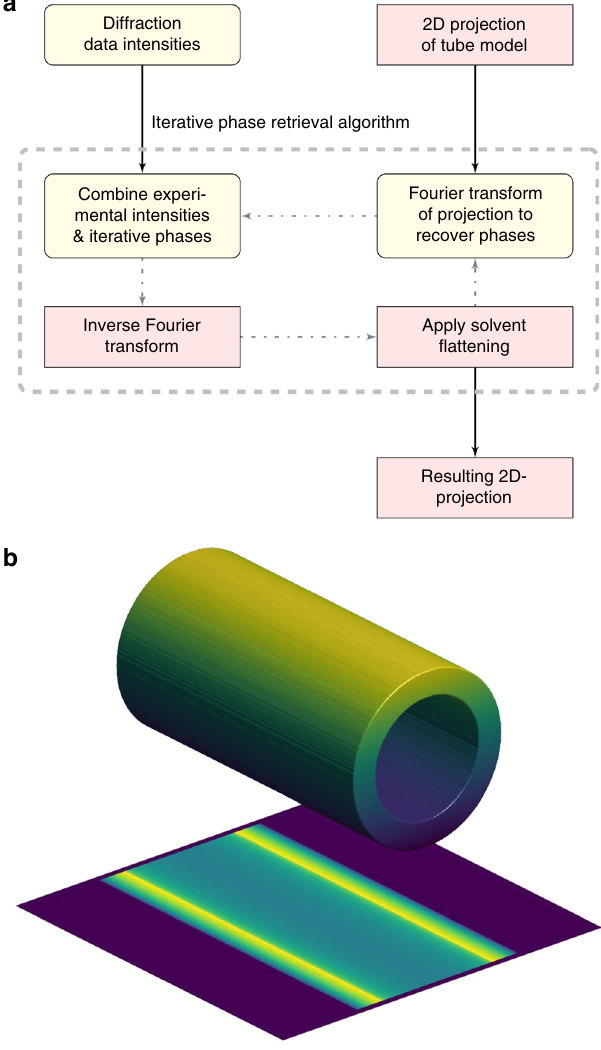
Fig. 4 Iterative phase retrieval algorithm. a Flow chart illustrating the input of X-ray diffraction data, initial phases, application of solvent fl attening (support function) and forward and backward Fourier transformations. Pink boxes represent real space and cream boxes represent reciprocal space. b Initial phases were provided from a projection of a featureless tube onto a